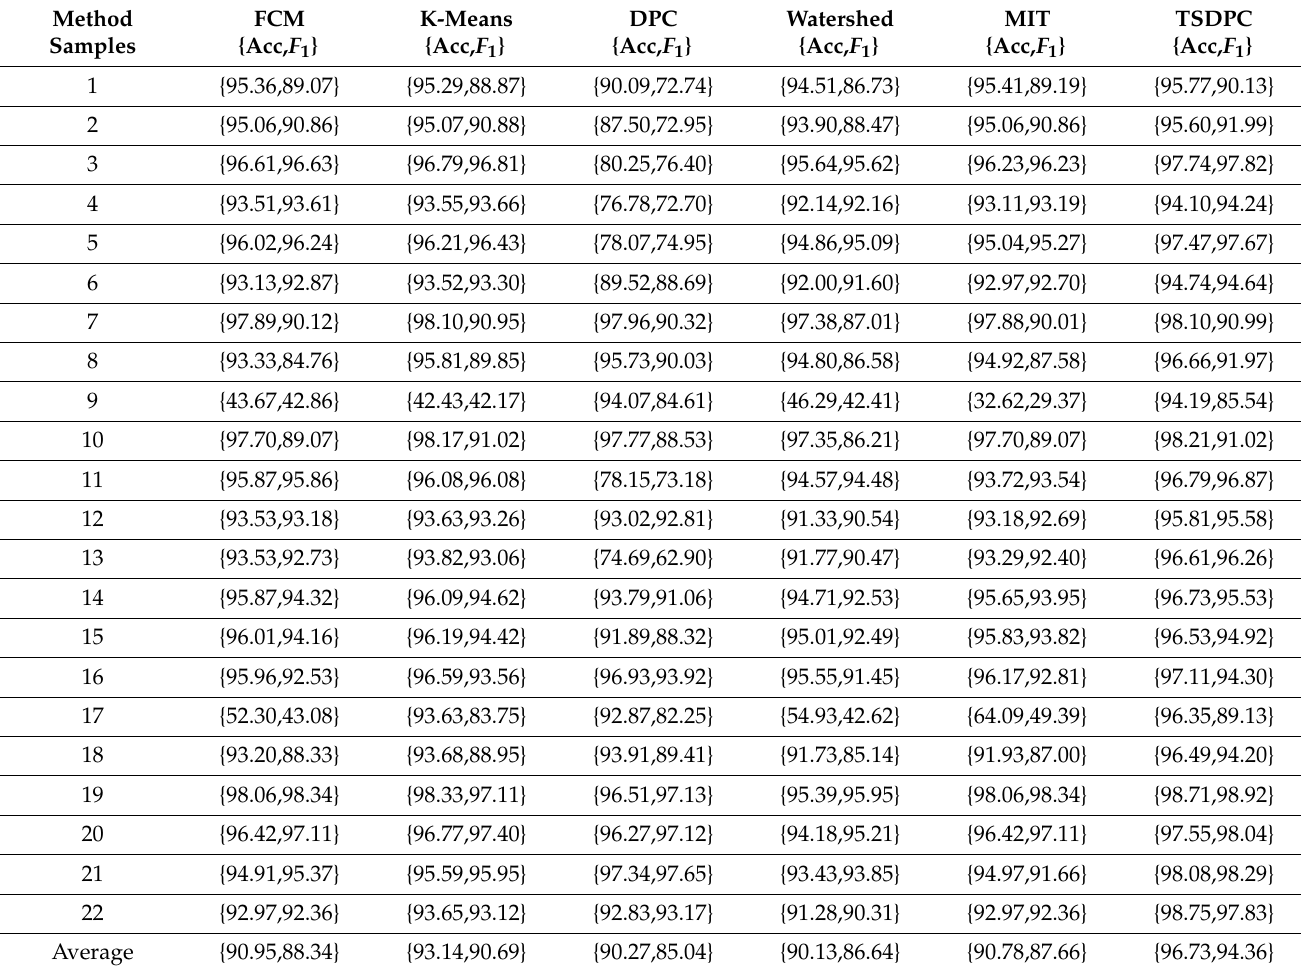
Table 1. Evaluation indicators of data statistics of six clustering algorithms (In %).